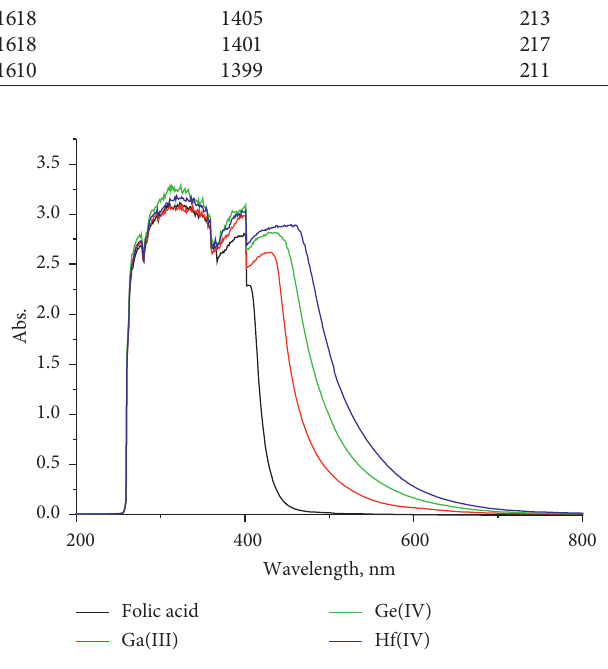
Figure 3: Electronic spectra of folic acid-free chelate and its Ga(III), Ge(IV), and Hf(IV) complexes. Table 3: The 1 HNMR spectral data of the FAH 2 and synthesized